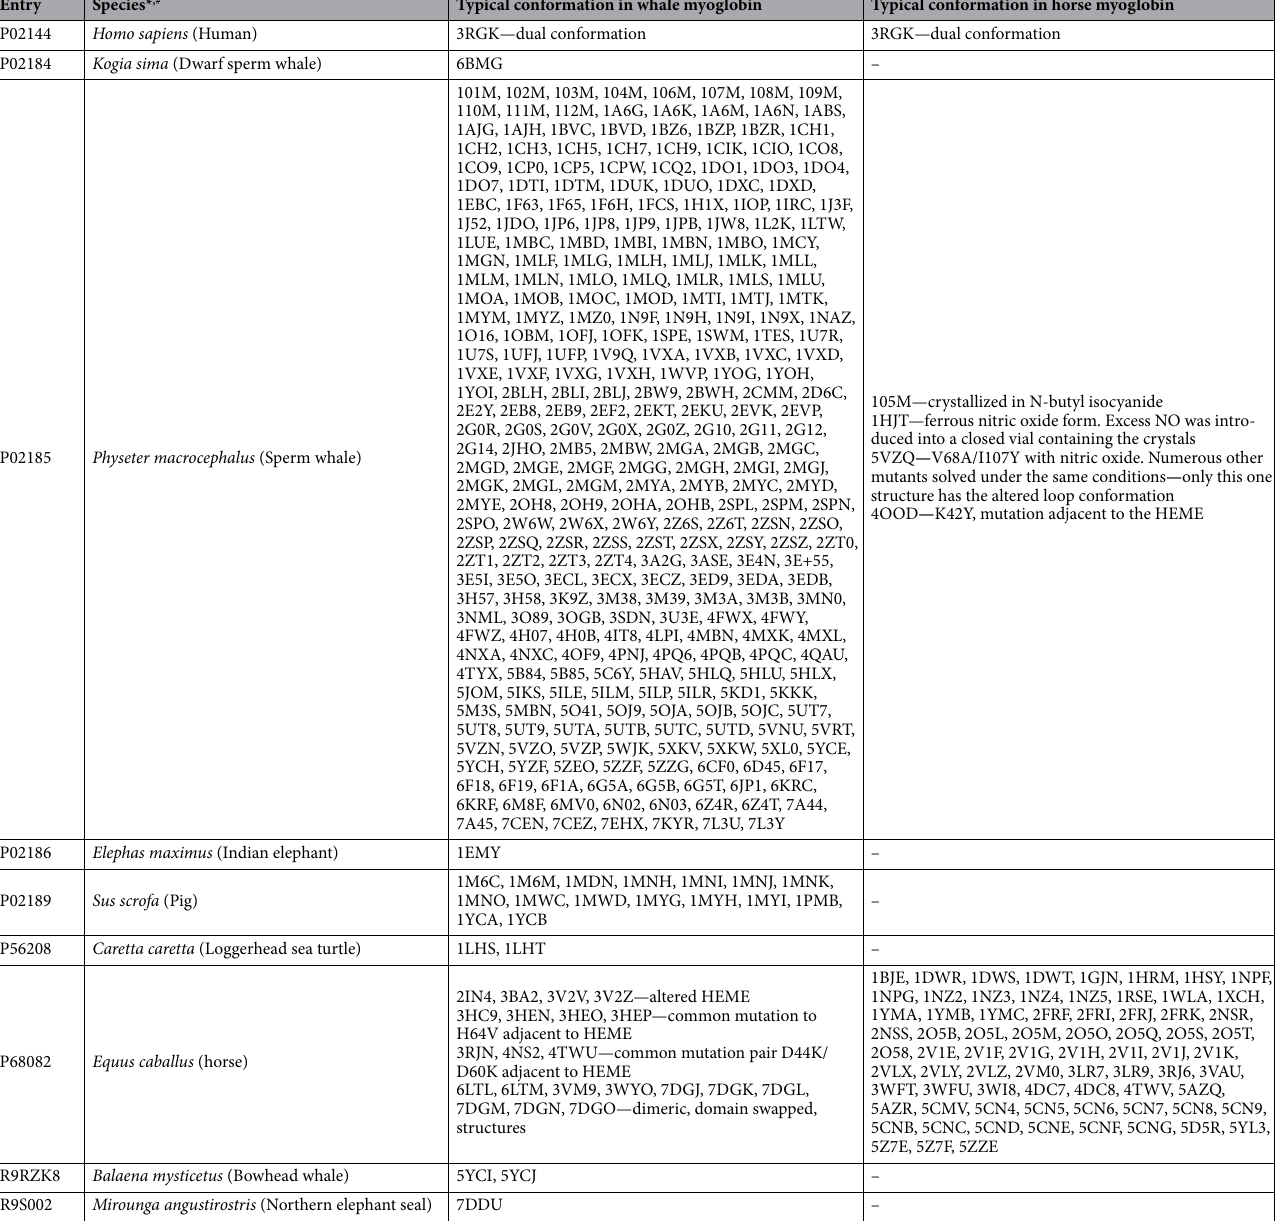
meric, domain-swapped structures. The association with heme binding is curious given that the loop in question is located on the opposite end of the protein, at least 25 Å away, and in a loop not observed to have an altered conformation in the apo protein 4 . It was demonstrated decades ago that heme binding occurs cotranslationally 5 ,